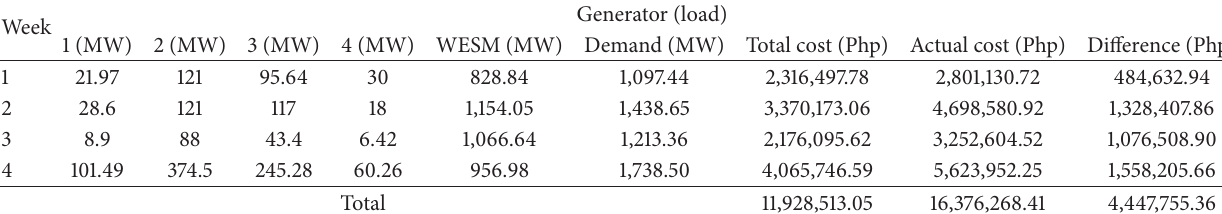
Table 3: Sample of weekly dispatch